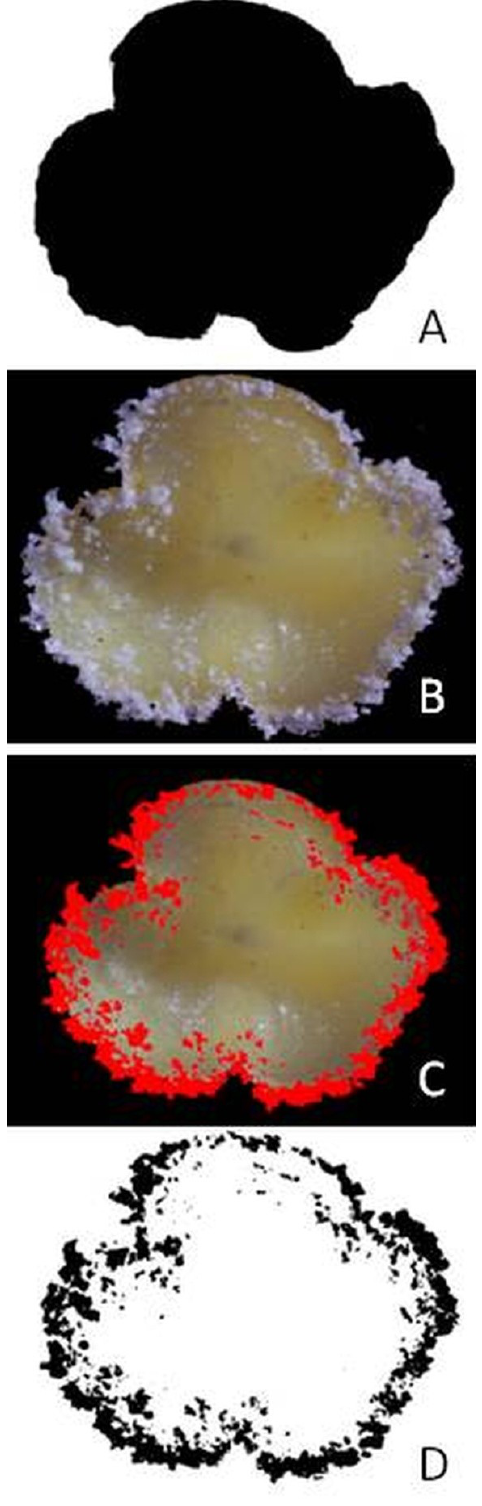
F IGURE 1. Quantifying the amount of pollen in the stigma photographs (stigmagraphs) with ImageJ Colour